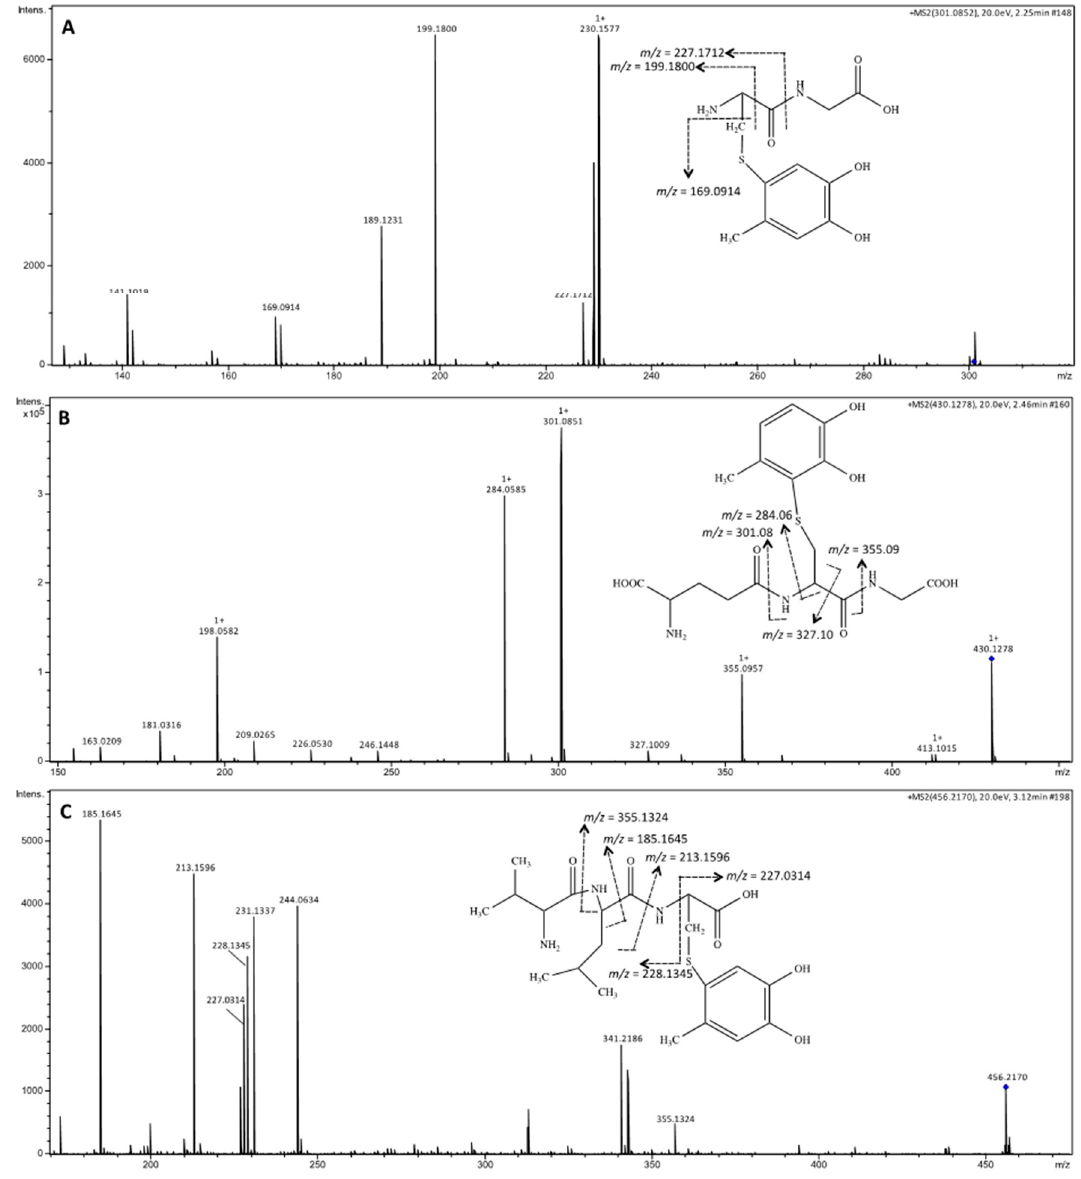
Figure 5. MS 2 spectra obtained after electrospray ionization of Nu-QH 2 derivatives in white wine samples. Precursors ions of identified nucleophiles ( A ) Cys-Gly-4MeC, ( B ) GSH-4MeC and ( C ) Val-leu-Cys-4MeC are indicated with diamonds ( ).